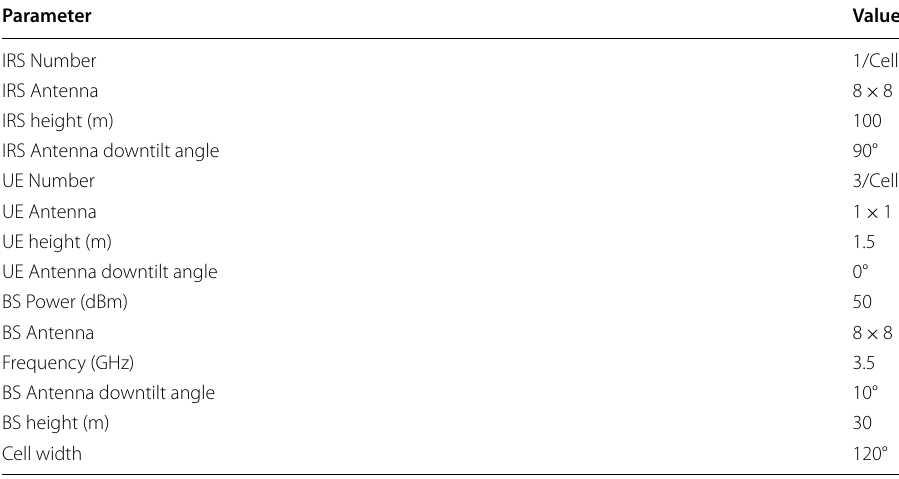
The simulation results are shown in Fig. 6